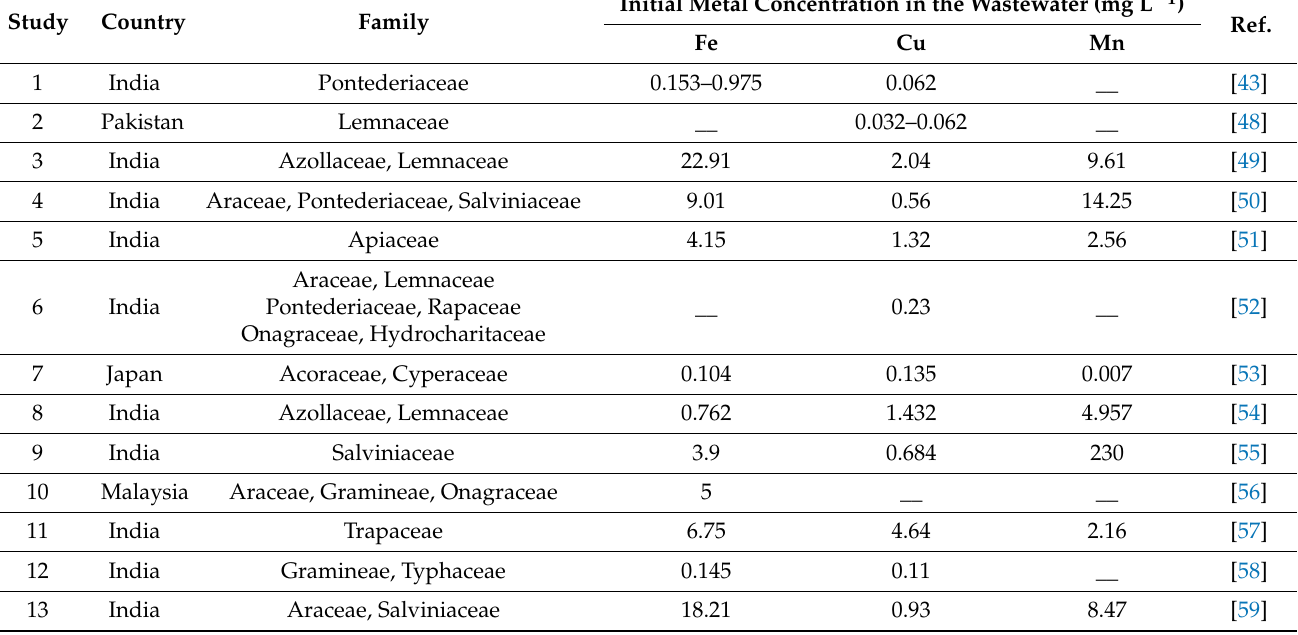
Table 1. Summary of some information extracted from the selected studies to evaluate the Fe, Cu and Mn uptake